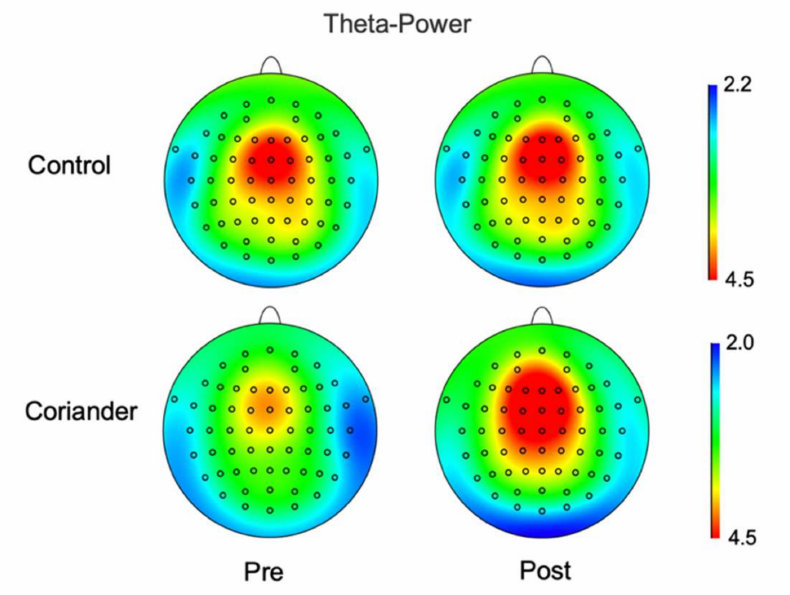
Figure 4. Theta wave power maps before and after homework in the coriander and control groups. The mean power in theta waves during the sit still for 5 min was analyzed and mapped it on the brain. Data presented as a variation ( n = 10).